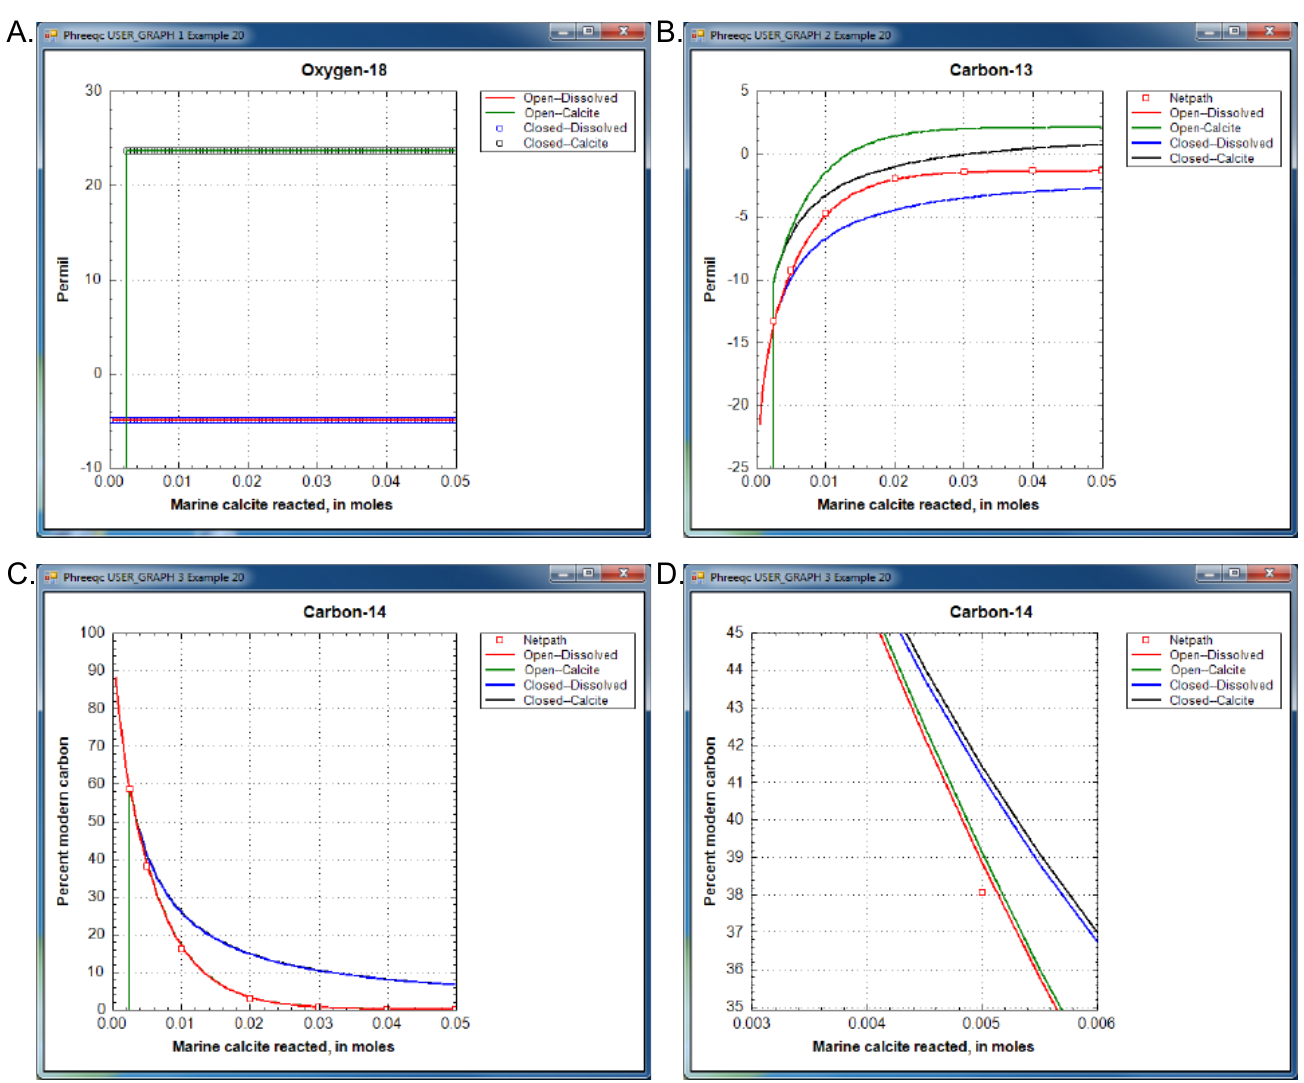
Figure 21. USER_GRAPH plots of example 20 open- and closed-system isotopic evolution for calcite and water: (A) oxygen-18, (B) carbon-13, (C) carbon-14, and (D) detail of